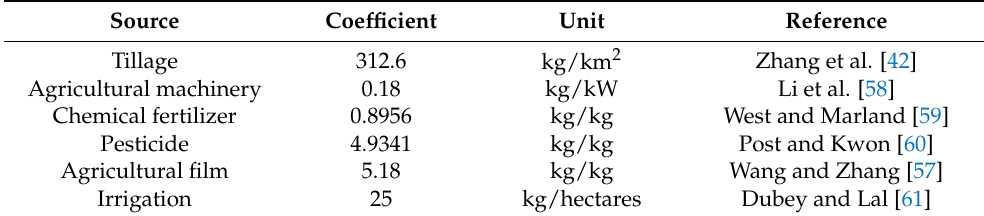
Table 3. Coefficients of major carbon sources during the process of ALU.